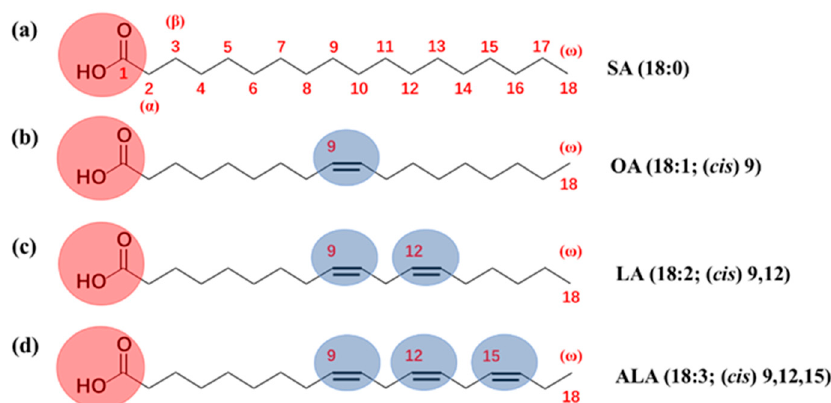
Figure 2. Molecular structures and saturation degree of SA, OA, LA and ALA. Table 1. Mainly physical properties of C 18 fatty acid.